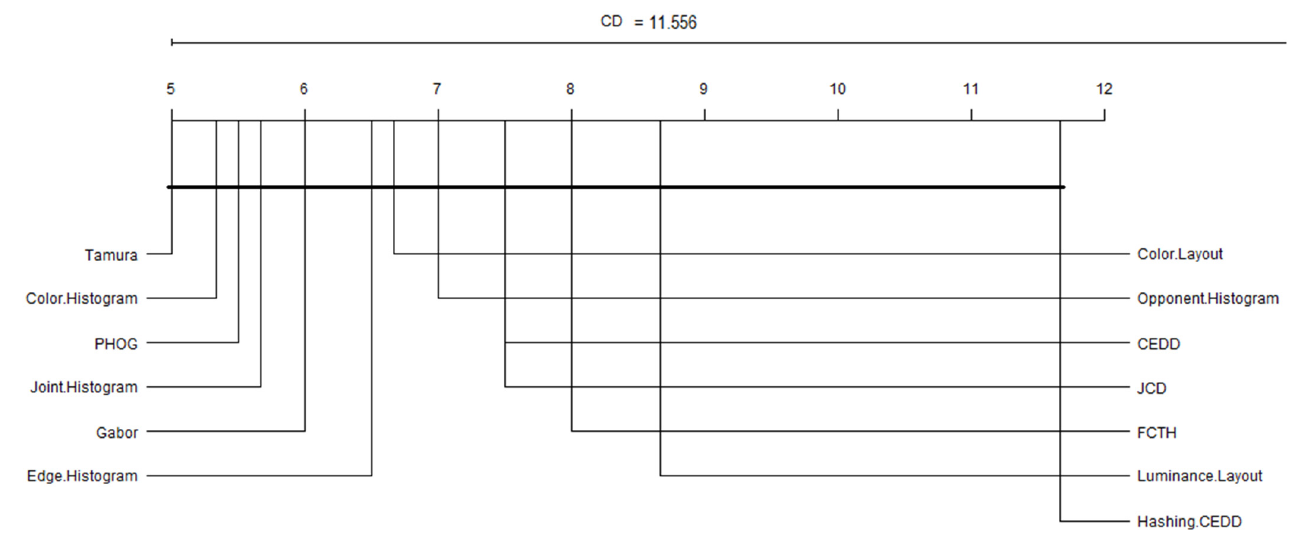
Figure 20. Critical Distance Diagram (CDD) for glow-affected face images.